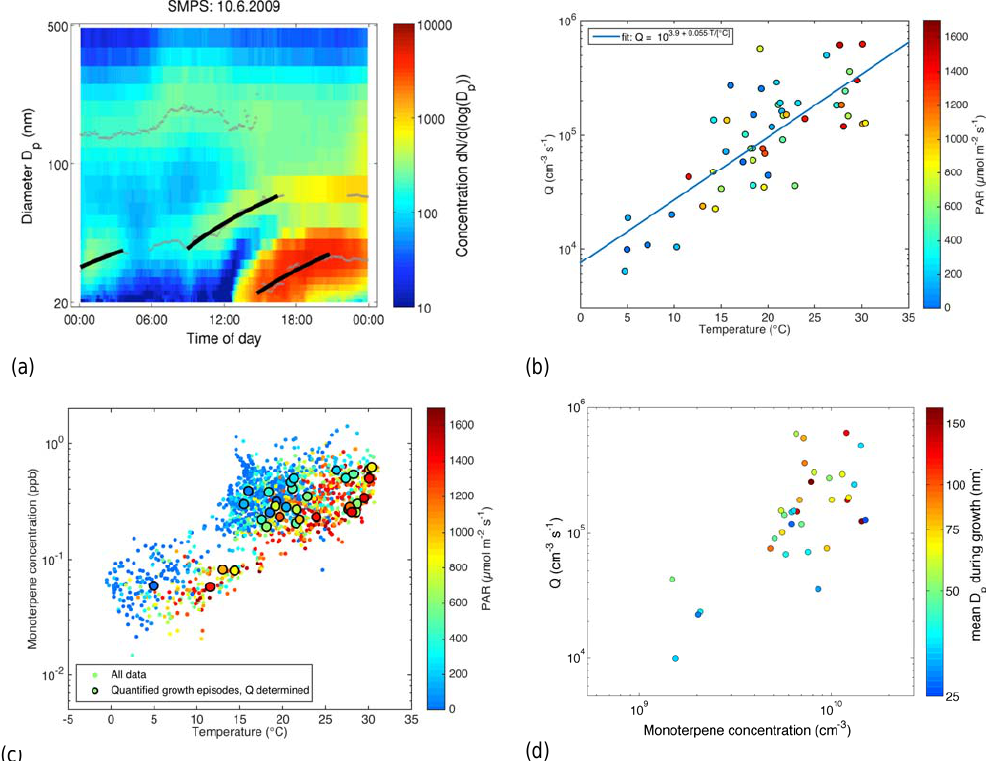
Figure 2. Particle growth rates obtained from particle number size distribution ( a , example from 10 June 2009). The colours indicate the measured concentrations (d N/ dlog D p , cm − 3 ) of particles with different diameters ( D p , nm) over the course of a day, small circles are mean diameters of concentration modes fitted for each measurement, and the temporal change of these diameters is represented with black lines from which the growth rate is calculated. Panel (b) shows the calculated volumetric source rates of condensing vapours ( Q , moleculescm − 3 s − 1 ; 10min resolution) as a function of air temperature ( ◦ C) for all identified growth periods (one data point is obtained for each fitted growth rate, e.g. from (a) three data points would have been extracted); data are separated by levels of photosynthetically active radiation (PAR). (c) Monoterpene concentrations (half-hourly data) measured above the canopy vs. temperature measured at the same level (data separated by PAR, the data points overlapping with determined growth rate in b are indicated by encircled symbols), and relationship between volumetric source rate of condensing vapours and monoterpene concentration ( d ; data separated by particle diameter). Data points in (d) correspond directly to encircled symbols in (b)